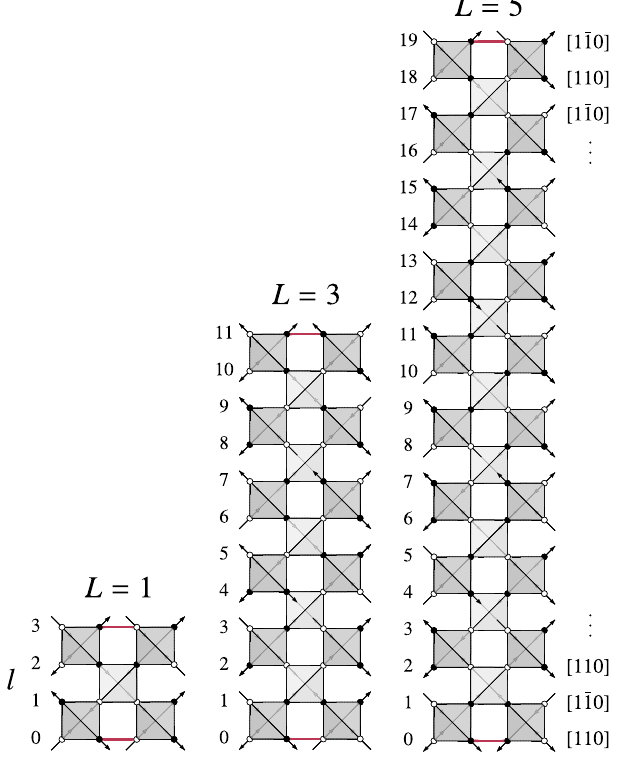
FIG. 3. Structure of [001] spin-ice films for the three thick- nesses discussed in the text ( L ¼ 1 , 3, 5). We show explicitly the layer index l , which runs from l ¼ 0 to l ¼ 4 L − 1 for a film of thickness L . Each layer contains two sublattices, α ¼ 2 l , 2 l þ 1 , of the primitive cell of the film (see Appendix B). The one- dimensional chains that comprise each layer alternate between 1¯10 orientations [110] and ½ (cid:3) from one layer to the next. Since the total number of layers, 4 L , is even, one surface has [110] chains 1¯10 while the other has ½ (cid:3)